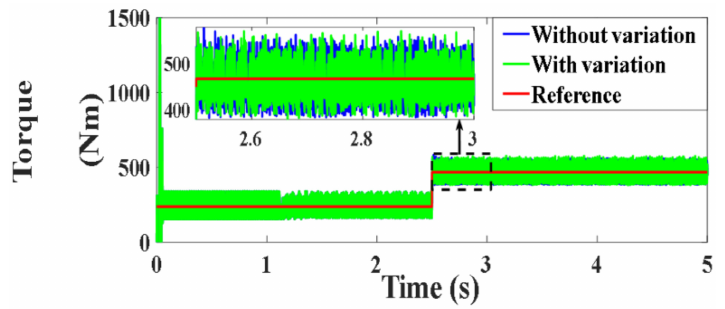
Figure 75. Developed torque under PVC (Nm).